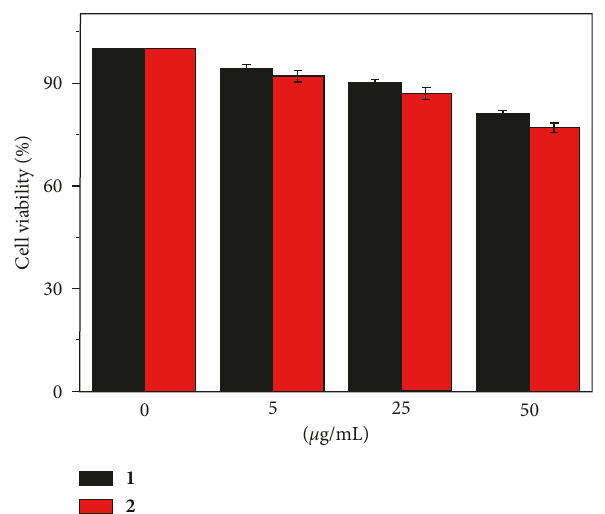
Figure 5: Cell viabilities of the oral epidermal cells after incubation with 1 and 2 at different